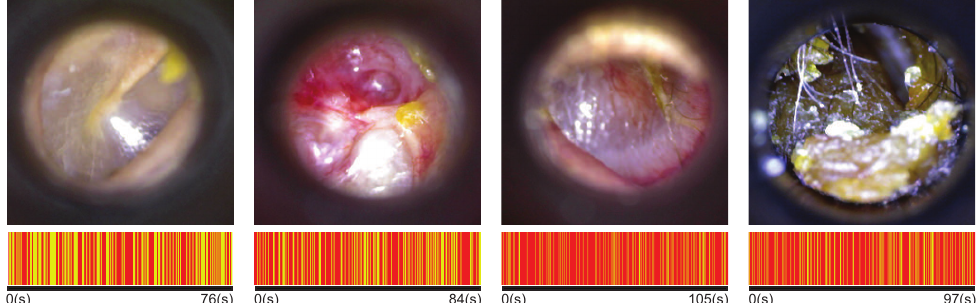
Figure 1. Upper row: eardrum imaging for each ear condition. From left to right: normal, chronic otitis media, otitis media with effusion, and earwax plug. Lower row: representation of the frames in a video, the yellow lines are those selected as